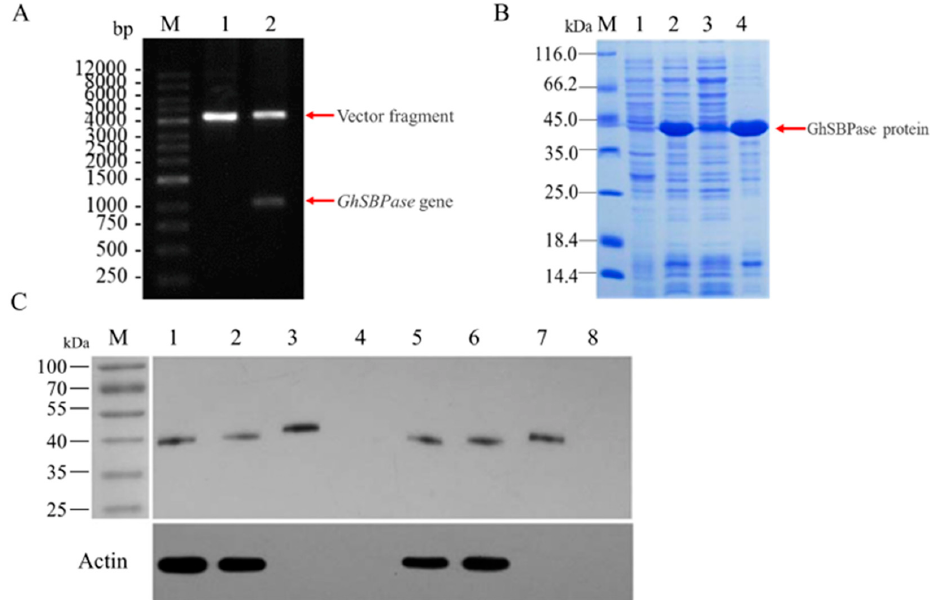
Figure 5. Western-blot analysis of GhSBPase protein in upland cotton. ( A ) Restriction enzyme di-